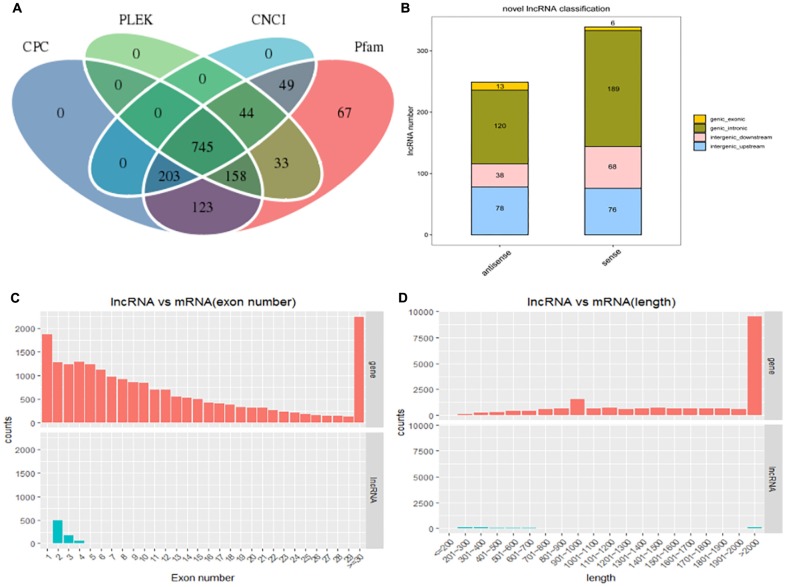
The long non-coding RNA (lncRNA) characteristic of yak skeletal muscle. (A) Venn diagram showing lncRNA transcripts from four datasets (CPC, CNCI, Pfam, and PLEK). (B) The positional relationship between lncRNA and known protein-encoded transcripts counting lncRNA types from four aspects: direction, type, location, and subtype. (C) The length distribution of lncRNAs and mRNAs. (D) The number of exons per lncRNA and mRNAs.